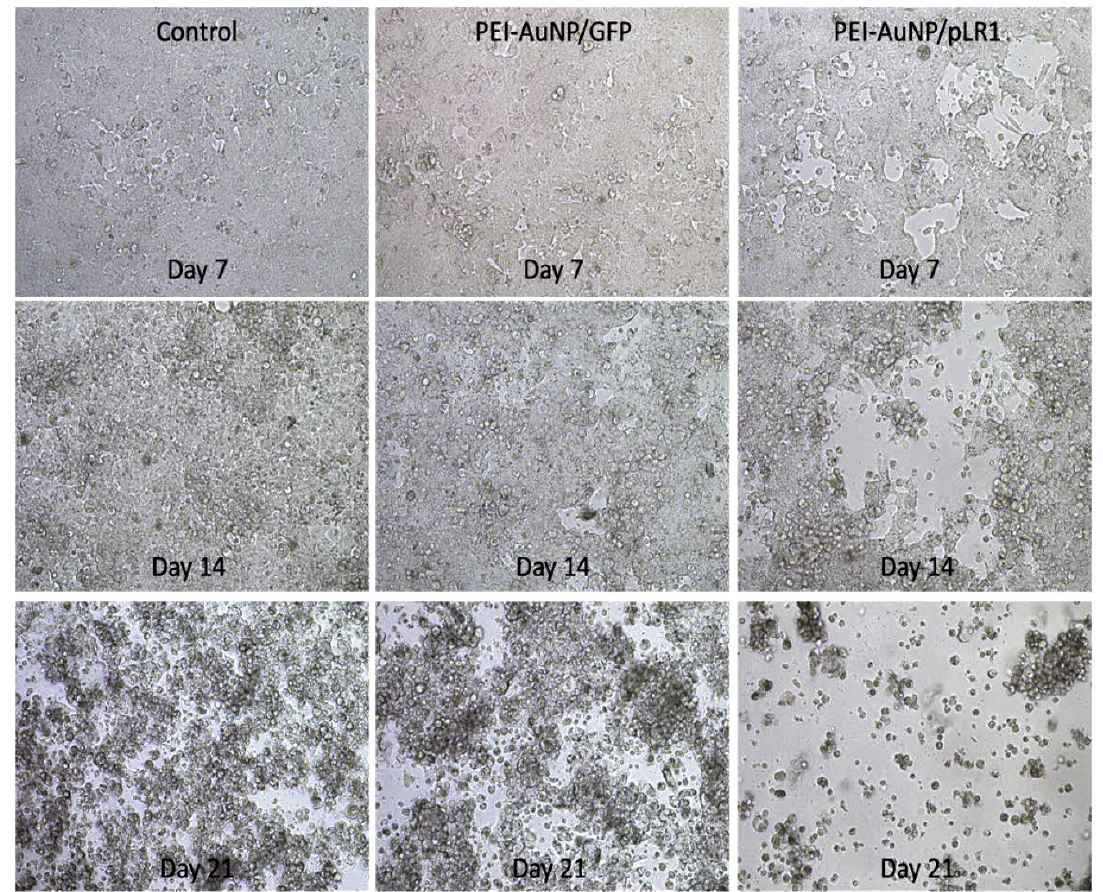
Figure 7. Oncolytic e ff ect of PEI-AuNPs / pLR1. This figure shows the di ff erent microscope images at 10 × of the SW480 cells taken at di ff erent days after transfections with PEI-AuNPs / GFP or PEI-AuNPs / pLR1 at 20 µ g / mL of DNA. Control corresponds to non-transfected cells.